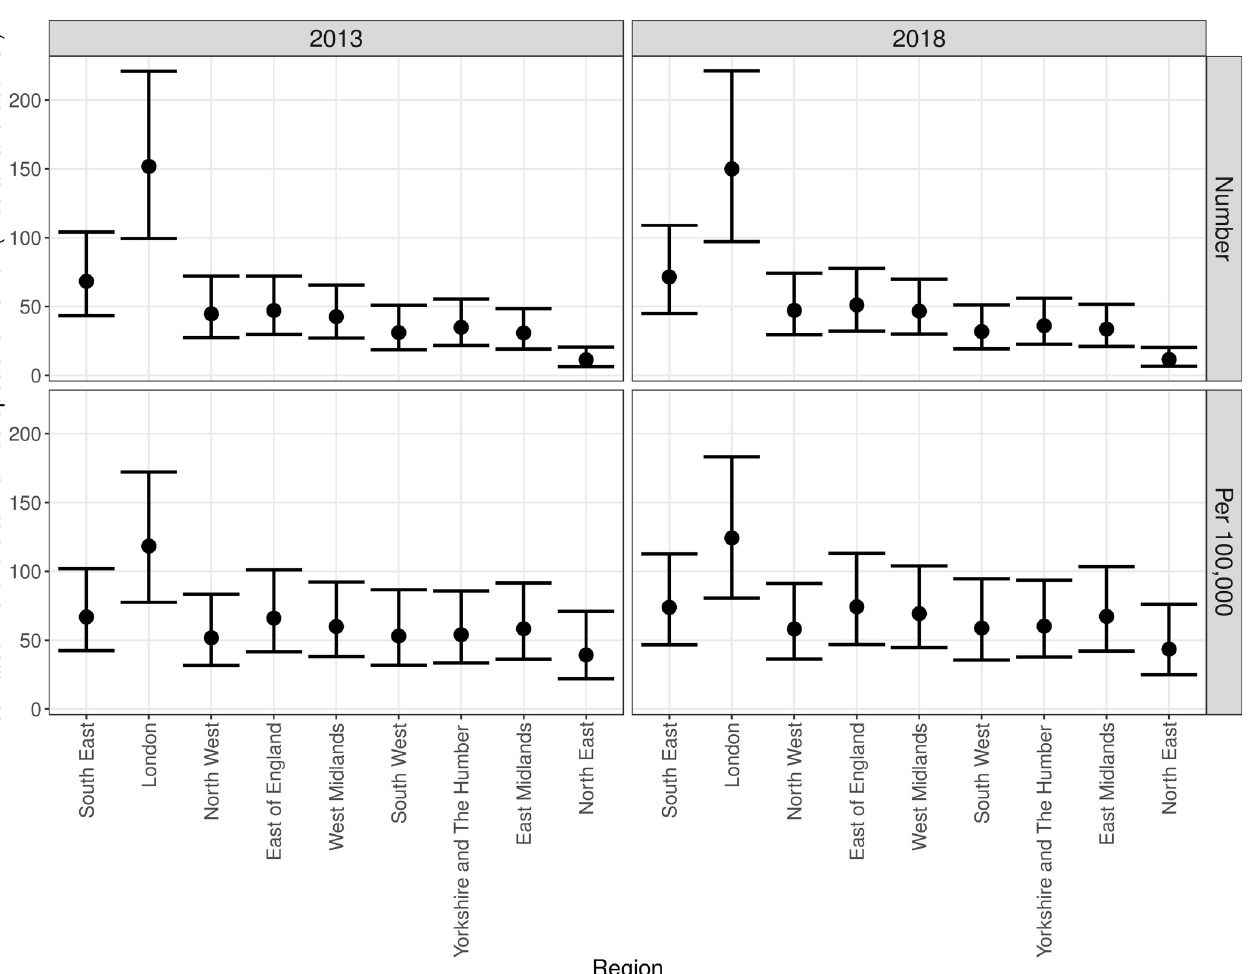
Fig 2. Estimated livebirths to HCV seropositive women expressed as absolute number and number per 100,000 livebirths, together with 95% credible intervals (CIs), for each region of England, for the years 2013 and 2018.